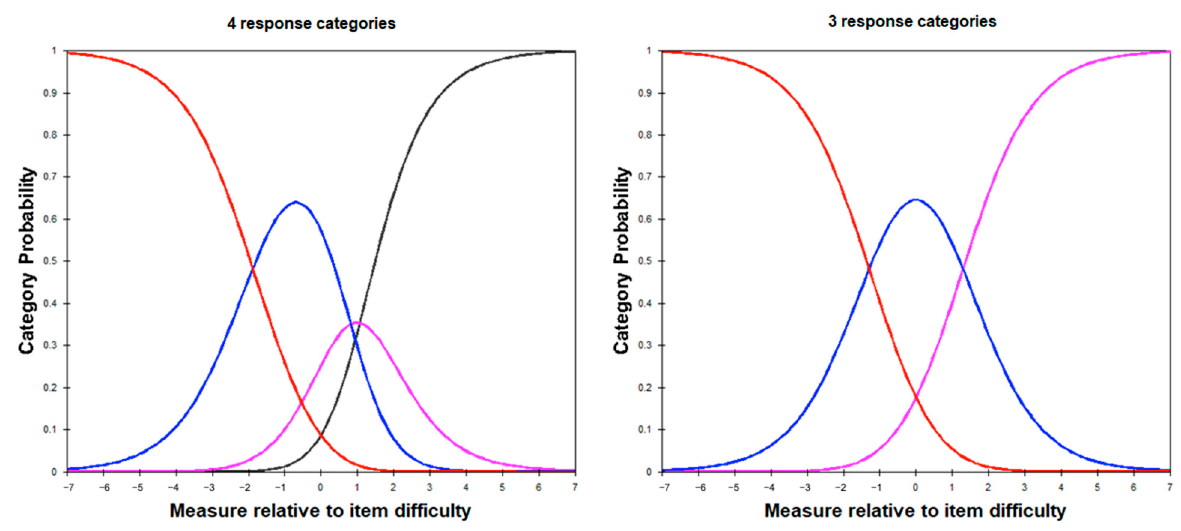
Figure 2. Response category curves for the original response category approach ( left ) and the modified approach with categories 3 and 4 collapsed to form a 3-point scale ( right ). As a partial-credit model was used due to the varying response categories between items, this figure used item 12 as an example.